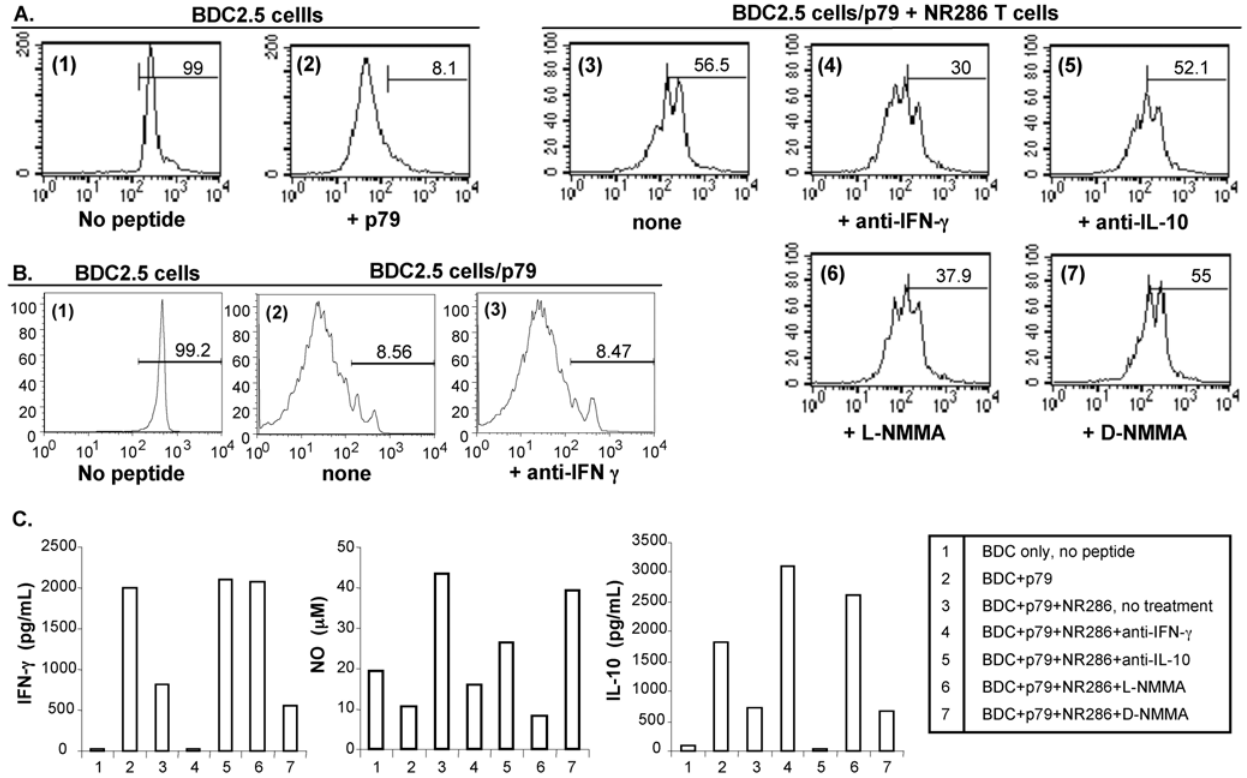
Figure 5. Blockade of IFN-- c and NO production abolished NR286 T cell regulatory function. ( A ) CFSE-labeled CD4 + BDC2.5 T cells (2 6 10 5 / well) were cultured under seven different culture conditions. In control cell cultures, BDC2.5 T cells were cultured in conditions of either (1) alone or (2) with p79 plus CD4 + cell-depleted irradiated APCs for activation. BDC2.5 T cells were also cultured with (3) an equal number of NR286 T cells. In some experiments, antibodies against (4) IFN- c or (5) IL-10 (24 m g/ml), and NO inhibitors, either (6) L-NMMA (active) or (7) D-NMMA (inactive) (0.2 m M), were added to the cultures to determine their effect on blocking the regulatory function of NR286 T cells. The number shown in each histogram represents the percentage of BDC2.5 T cells that underwent , 2 rounds of cell division. Data are from at least 2 experiments. ( B ) CFSE- labeled CD4 + BDC2.5 T cells (2 6 10 5 /well) were cultured under three conditions. Similar to those in (A), in control cell cultures, BDC2.5 T cells were cultured in conditions of either (1) alone or (2) with p79 plus CD4 + cell-depleted irradiated APCs for activation. BDC2.5 T cells were also cultured with (3) antibody against IFN- c (24 m g/ml), in the absence of NR286 T cells. (C) Cell culture supernatants from (A) were harvested for ELISA to detect the presence of IFN- c , IL-10, and